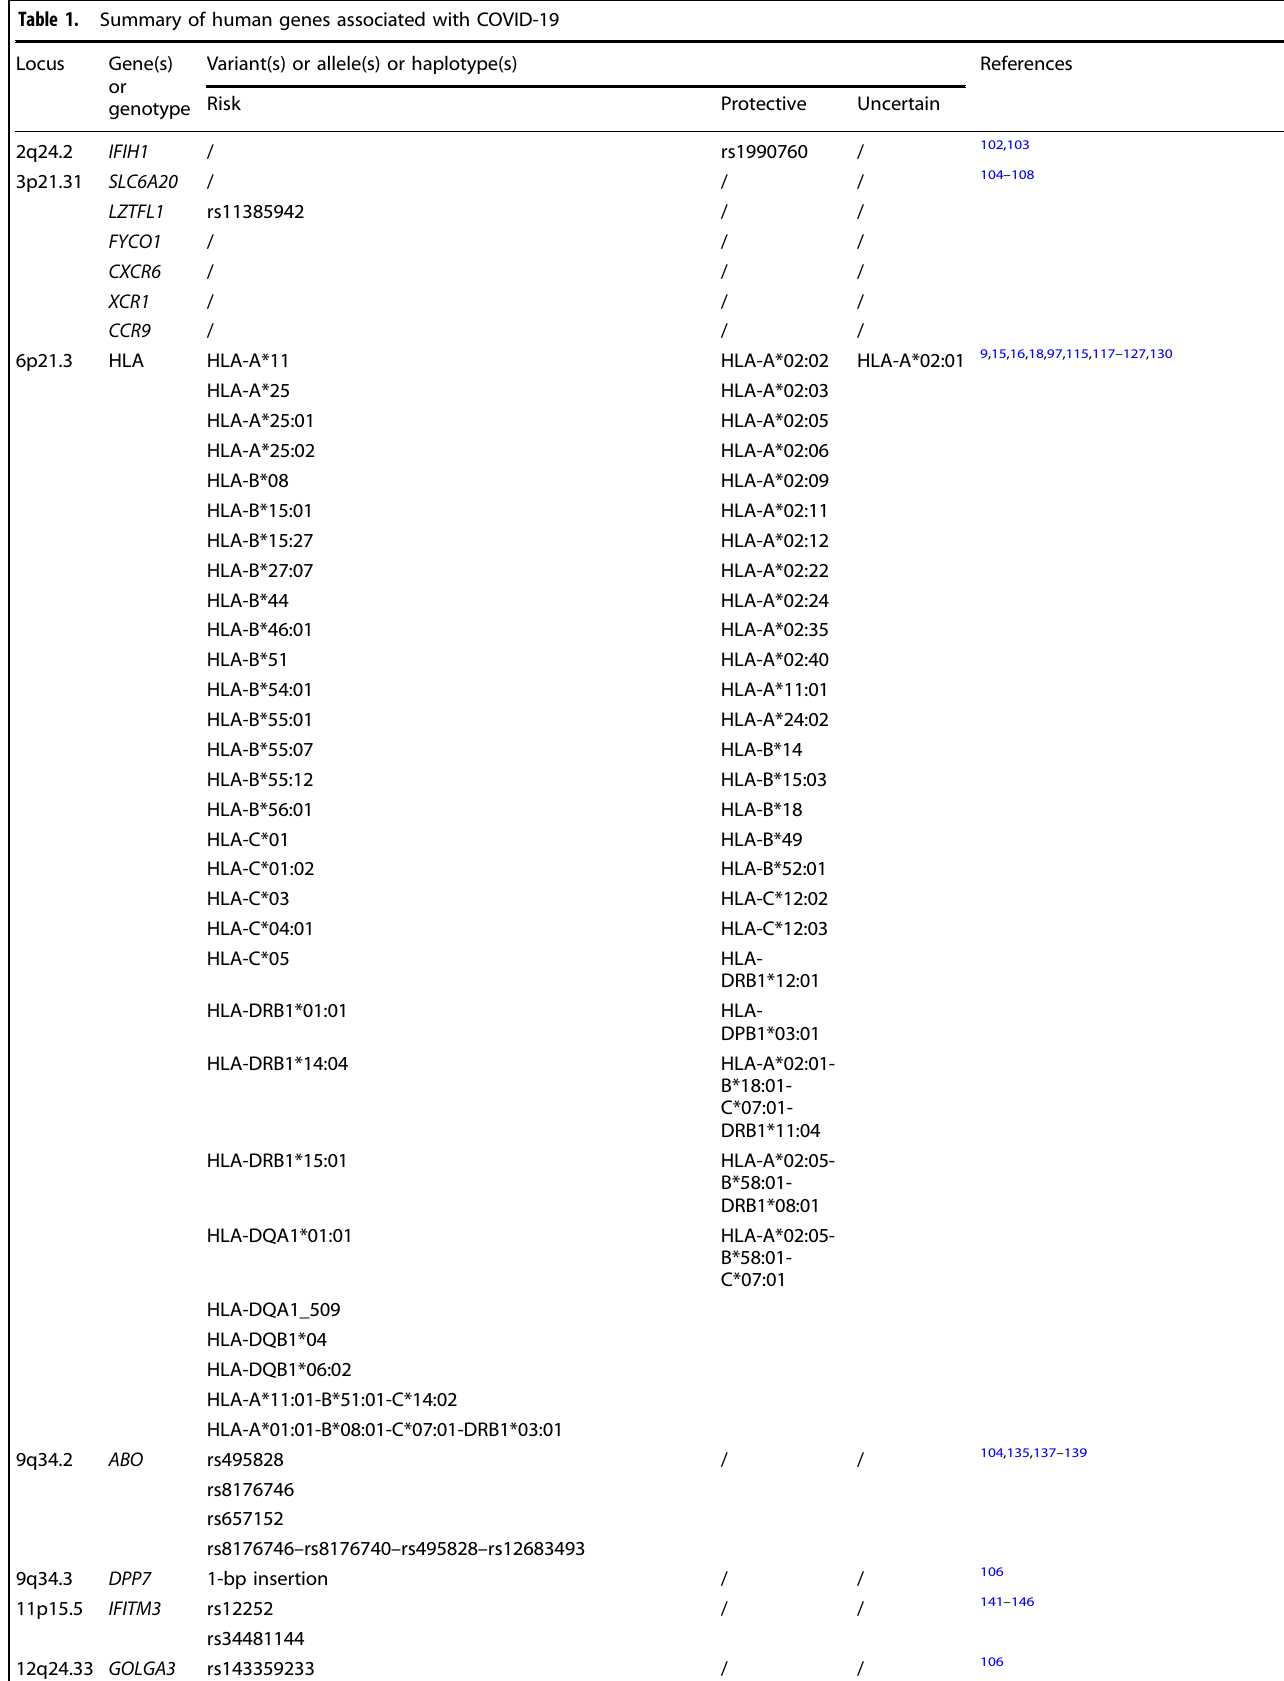
Table 1. Summary of human genes associated with COVID-19 Locus Gene(s) Variant(s) or allele(s) or or genotype